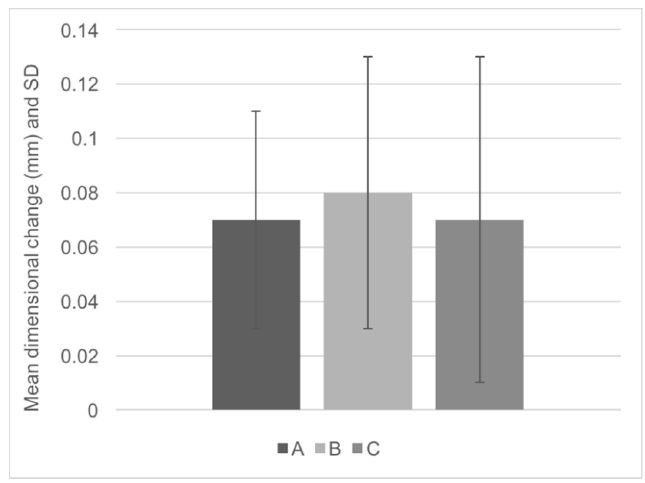
Figure 3. Mean (standard deviation) dimensional change (mm).